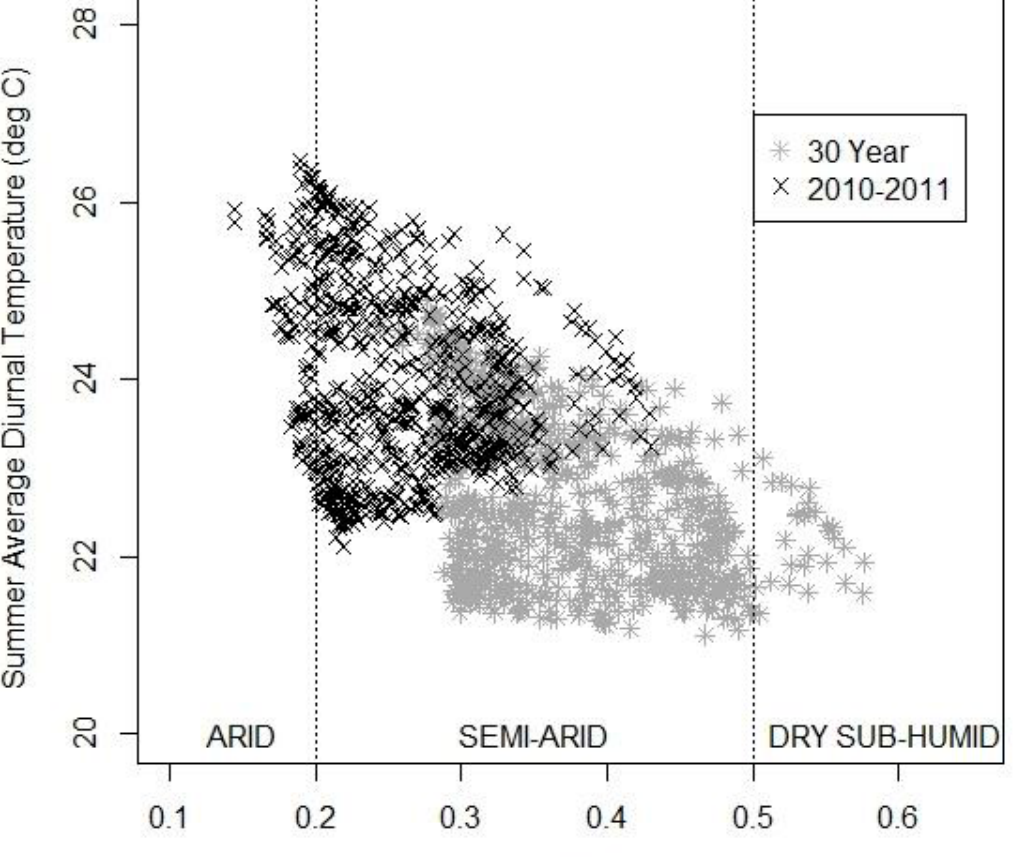
Figure 7. Spatially aggregated comparison of the NJF's Mean Annual Aridity Index versus Summer (December, January and February) Average Diurnal Temperature Range (deg C). Averages over the period 1981–2009 are shown in grey and the 2010–2011 in